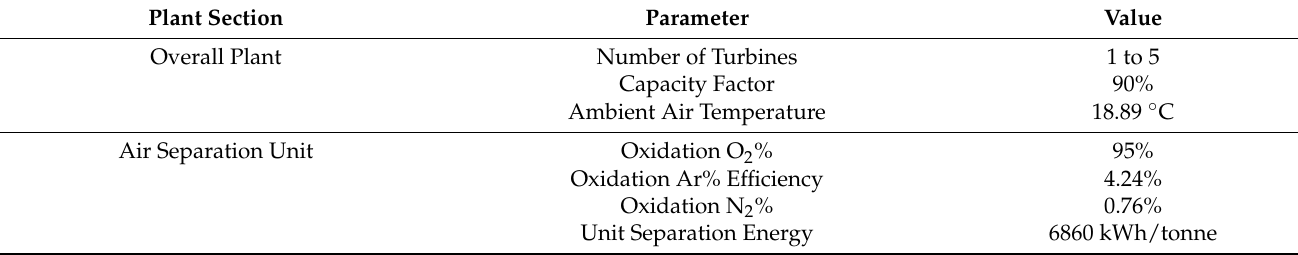
Table A11. Modeling parameters used for integrated gasification combined cycle (IGCC) powerplants in the IECM. Plant